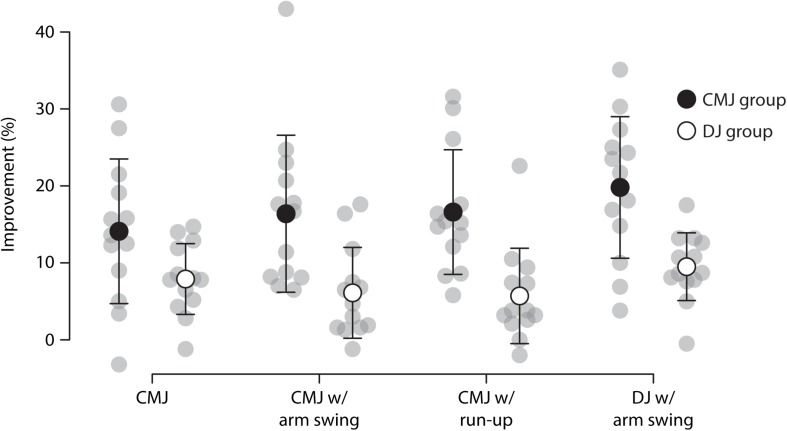
Percent improvement for the countermovement jump (CMJ; filled circles) and the drop jump (DJ; open circles) training groups in the four jump types. Gray circles represent the individual participants. Error bars represent the standard deviation.